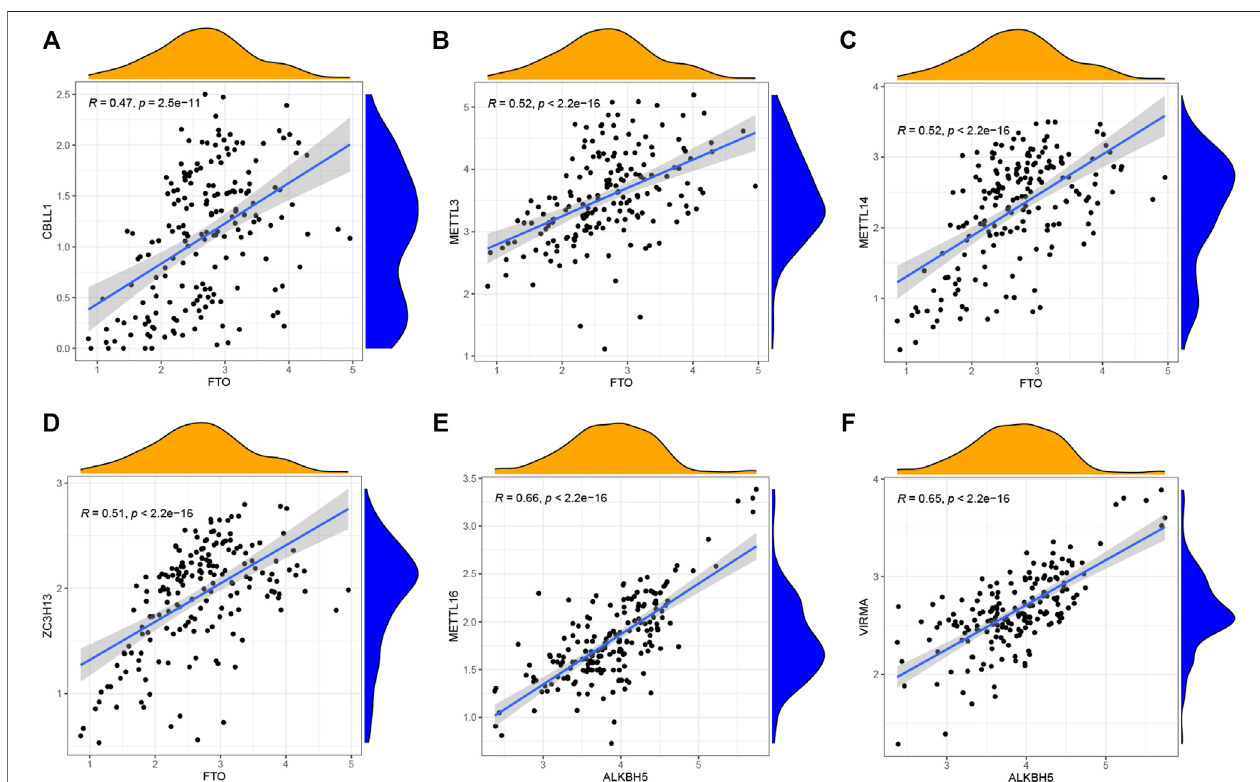
FIGURE 2 | Correlation between writers and erasers in CHP and IPF (A – F) Writer genes: CBLL1, METTL3, METTL14, ZC3H13, METTL16, and VIRMA. Eraser genes: FTO and ALKBH5 (|R| > 0.4 and p < 0.001). R, correlation coef fi cient.